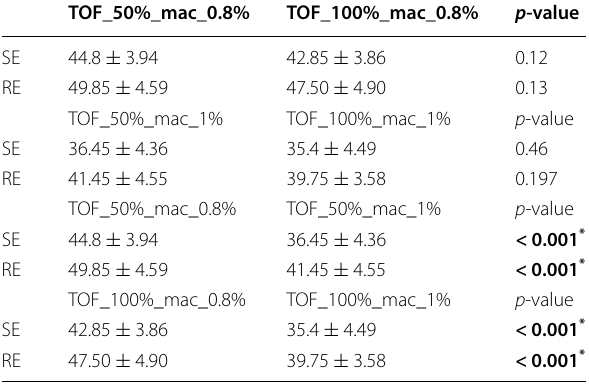
* Indicates comparison between mac 0.8 and mac 1% showed significant value at both TOF 50% and 100%